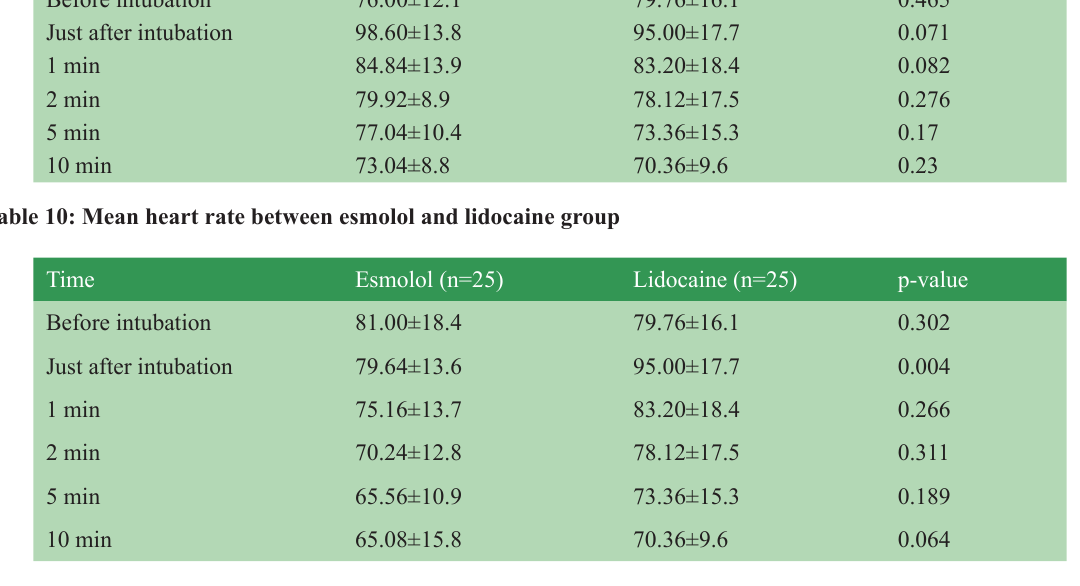
Table 9: Mean heart rate between placebo and lidocaine group Time